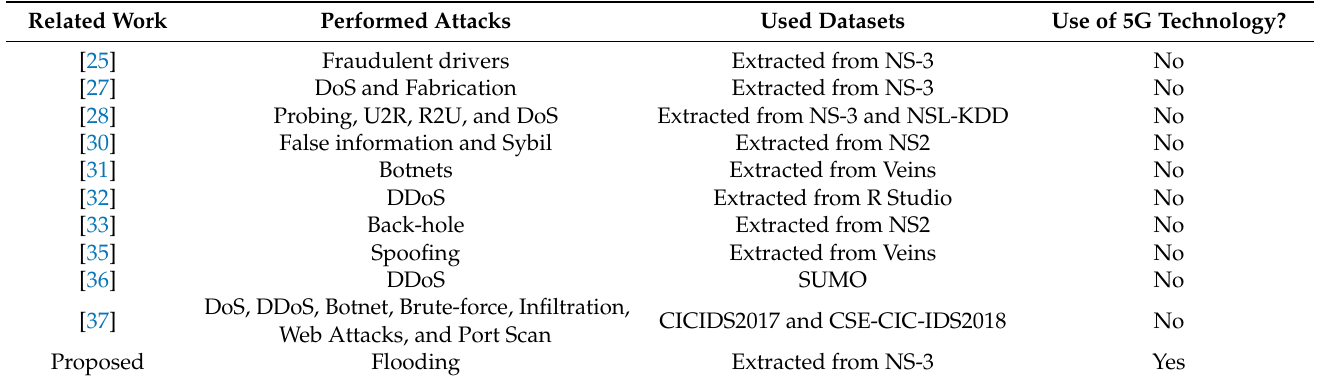
Table 1. Summary of related